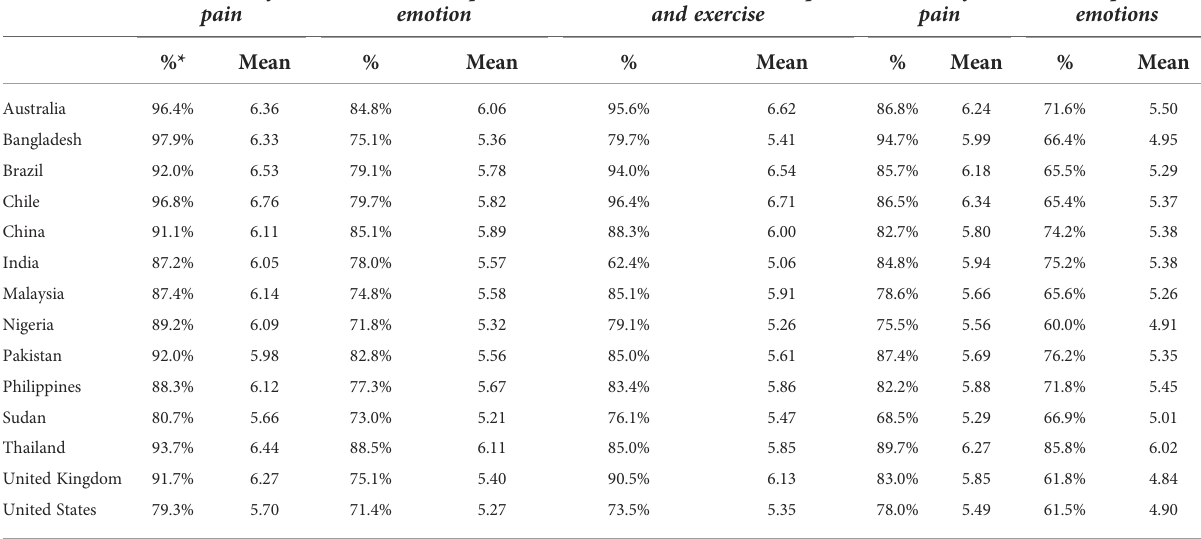
TABLE 5 Means for the level of agreement with species speci fi c experiential statements, by country utilizing 7-point Likert scale, and percentage of general agreement with statement. Chickens can feel Chickens can experience Chickens needs room to explore pain emotion and